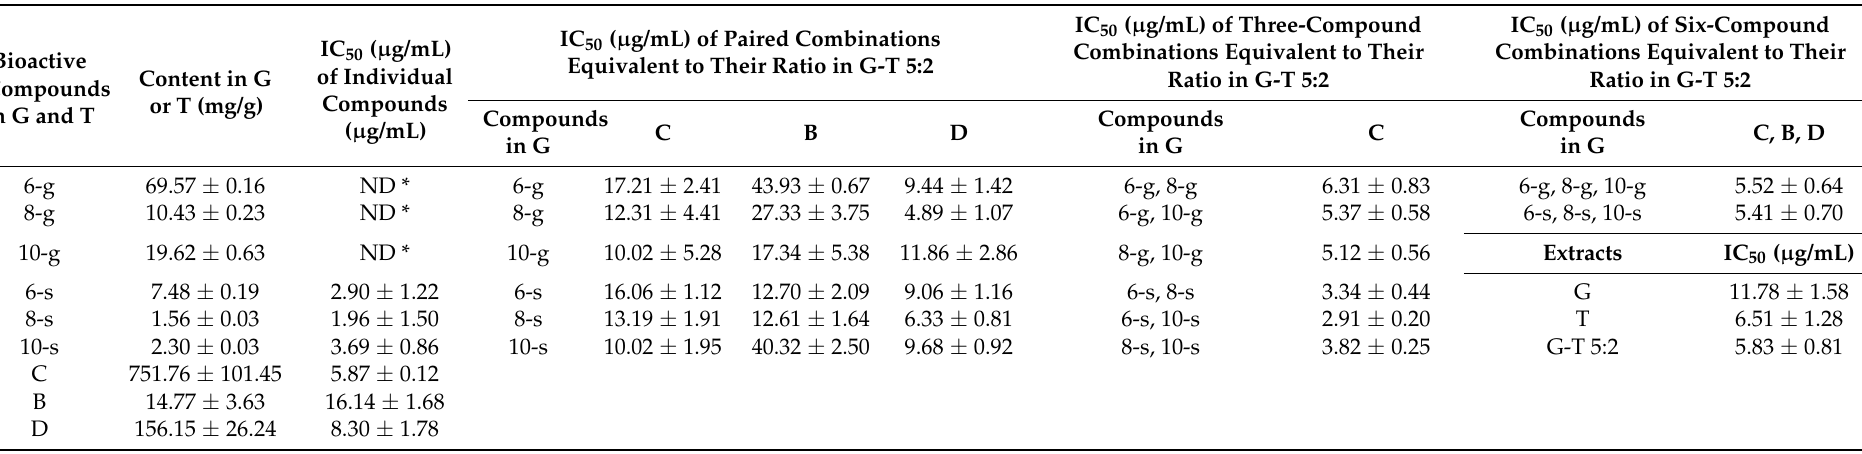
Table 3. Inhibitory effects of individual and combined bioactives of ginger (G) and turmeric (T) in inhibiting LPS-induced NO expression in RAW 264.7 cells ( n >